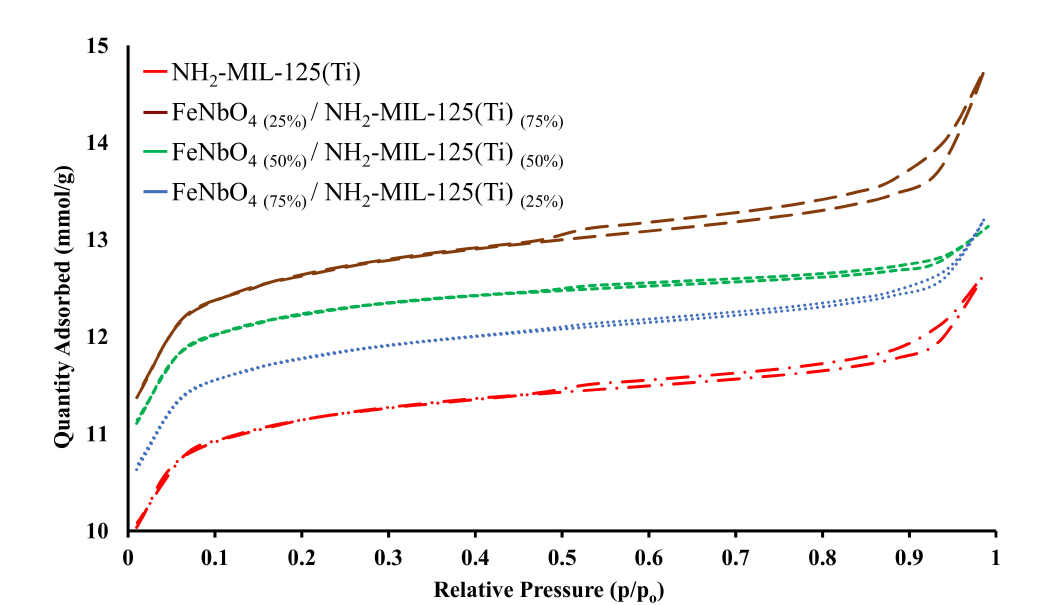
Figure 5. N 2 adsorption-desorption isotherm of pure NH 2 -MIL-125(Ti) and the three different mole ratio composites of FeNbO 4 /NH 2